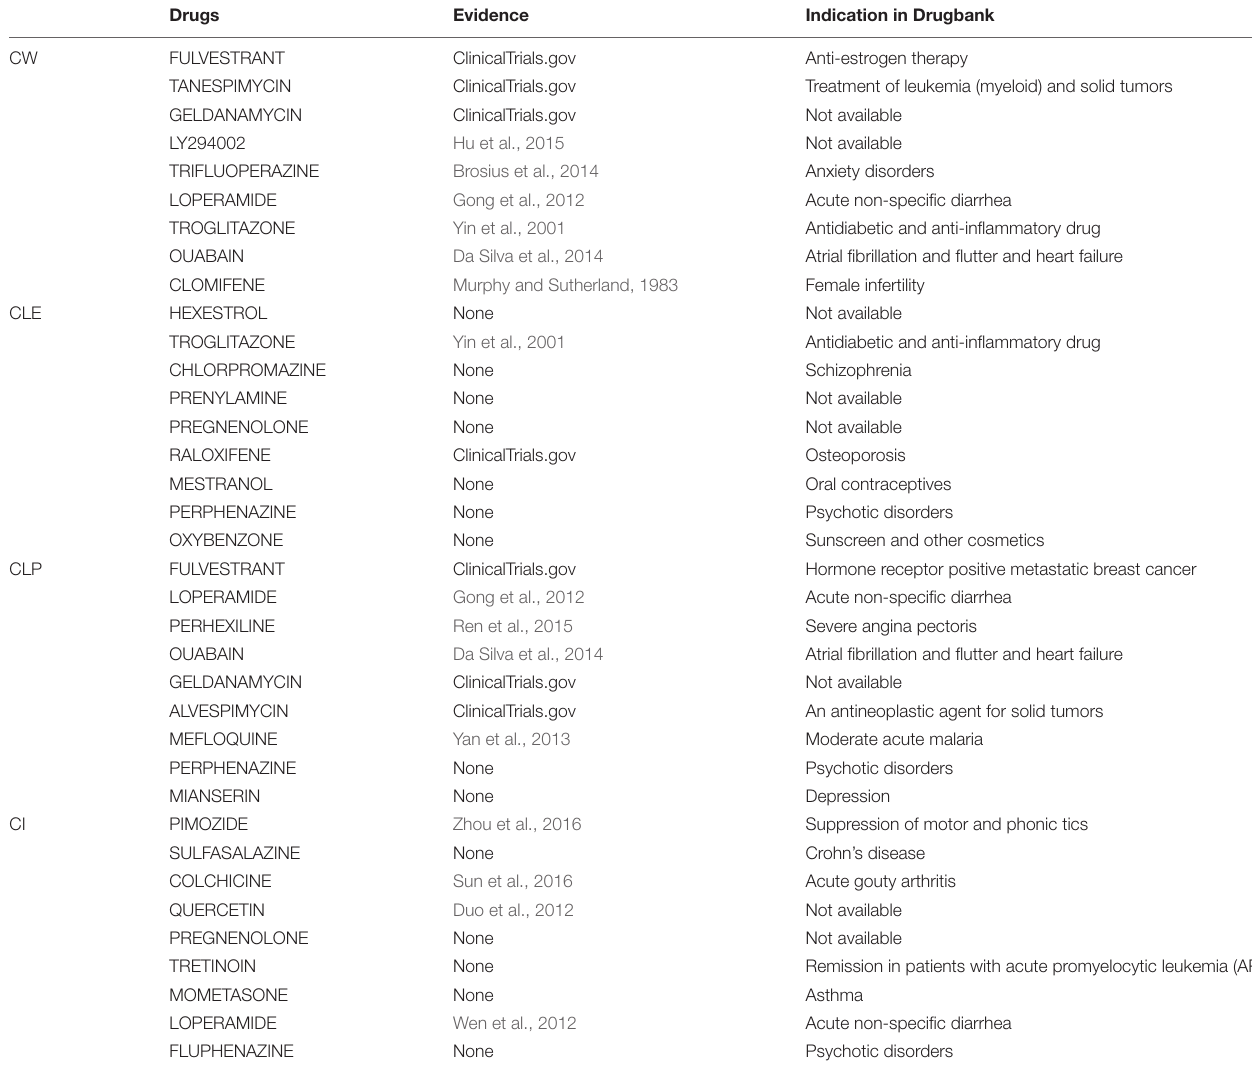
TABLE 3 | Top nine potential anti-breast cancer drugs generated by the four algorithms. Drugs Evidence Indication in